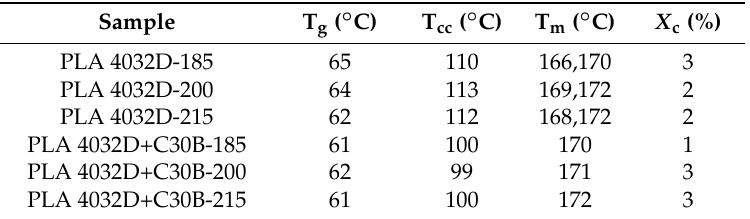
Table 8. Thermal temperatures, enthalpies and degree of crystallinity of PLA 4032D and PLA 4032D+C30B printed specimens (first heating).